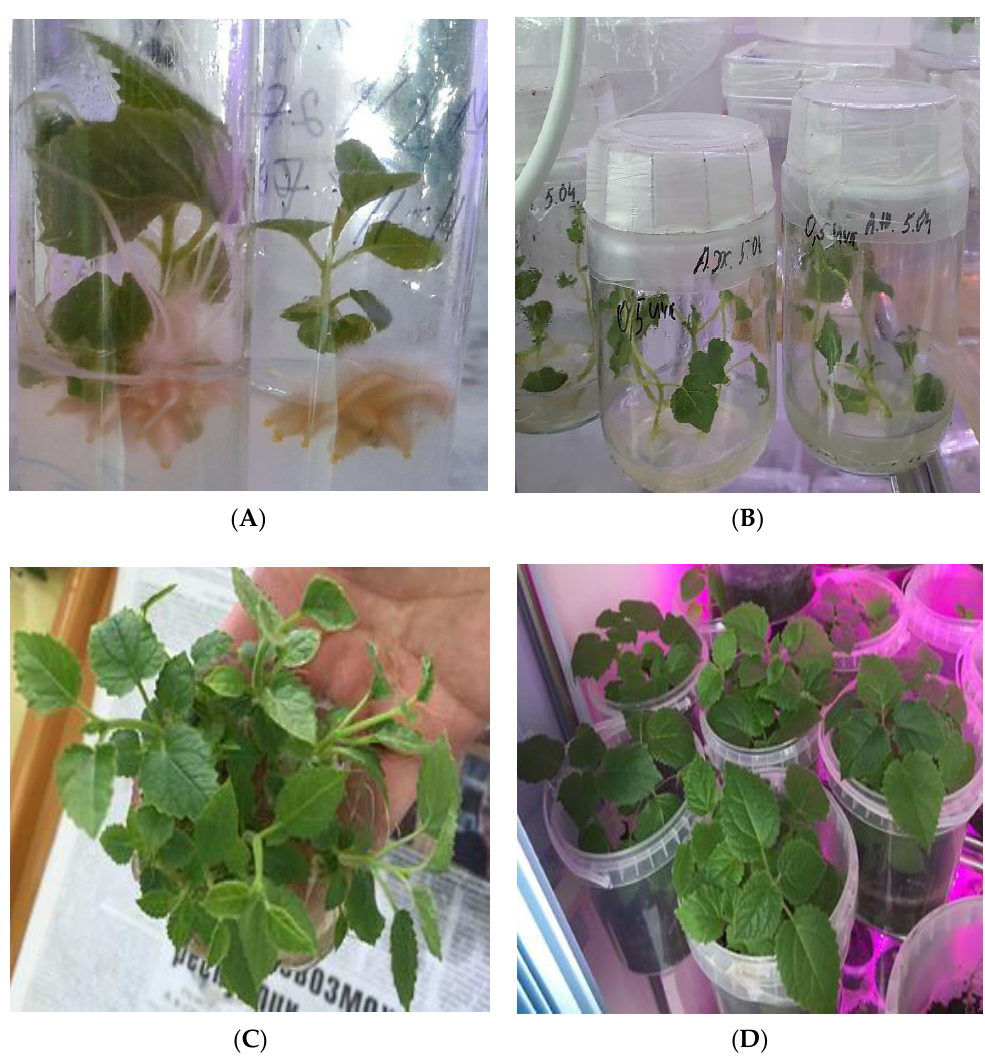
Figure 4. Rooting of regenerated plants on ½ MS media with 5.4 µM NAA and transfer of rooted plants to soil: well rooted shoots in vitro ( A,B ), after rooting plants transferred to the soil ( C,D ). Increasing the concentration of IAA and NAA up to 11.4 µM and 10.7 µM,